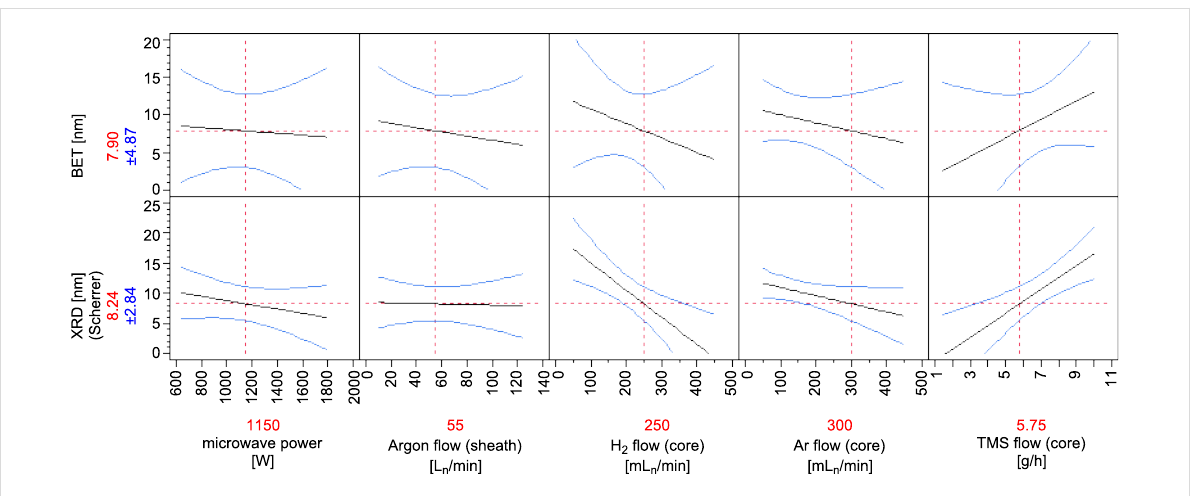
Figure 5: Response plot of the particle sizes based on adsorption measurements (BET, upper row) and on Scherrer’s equation (XRD, lower row). The black straight lines indicate the calculated linear dependence of the response value from the experimental factors. The blue curves show the 95% confidence limits of the linear correlations. The red dotted lines and values indicate the centre values of the factors. On the ordinate the calculated response values are shown with the error within the 95% confidence intervals in blue.